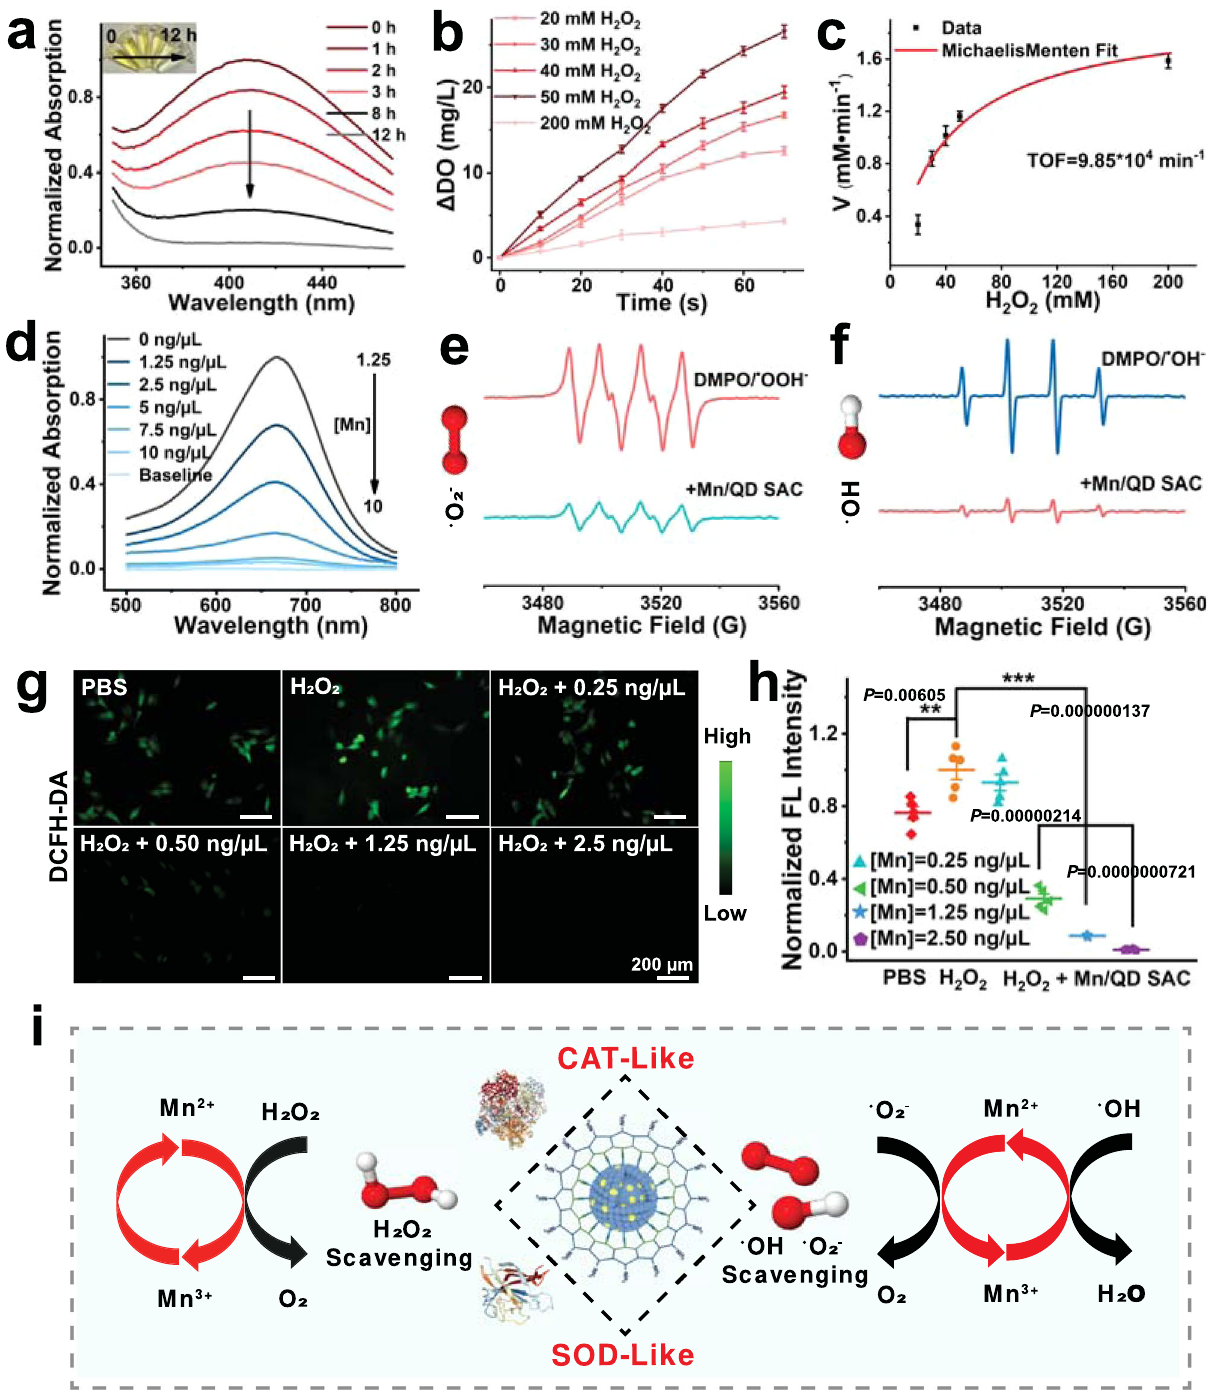
Fig.3|Enzyme-mimeticandROSscavengingactivityoftheMn/QDSAC.a Time- dependent absorption spectrum with Mn/QD SAC in titanium sulfate colorimetry method. b Oxygen generationinvarious concentration of H 2 O 2 solutions with Mn/ QD SAC. Data are presented as mean±SD ( n =3 independent samples). c Steady- state kinetic analysis for the CAT-like activity of Mn/QD SAC. The TOF were obtained from the Michaelis – Menten equation. Data are presented as mean±SD ( n =3 independent samples). d Concentration-dependent absorption spectrum with Mn/QDSAC forthe • O 2 − scavenging inNBTmethod. e ESR spectraof • O 2 − with Mn/QD SAC using DMPO as the spin trap agent. f ESR spectra of • OH with Mn/QD